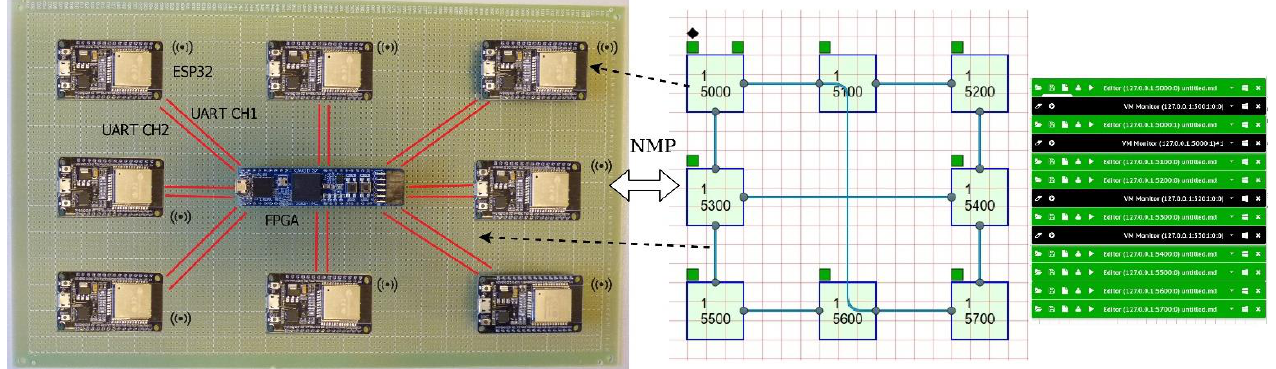
Figure 2. ( Left ) Prototype of the distributed-parallel multicomputer with 8 embedded ESP32 nodes and an FPGA-based internal network switch ( Right ) VNetOS GUI representation of the network (green box: editor, black rombus: VM instance monitor).